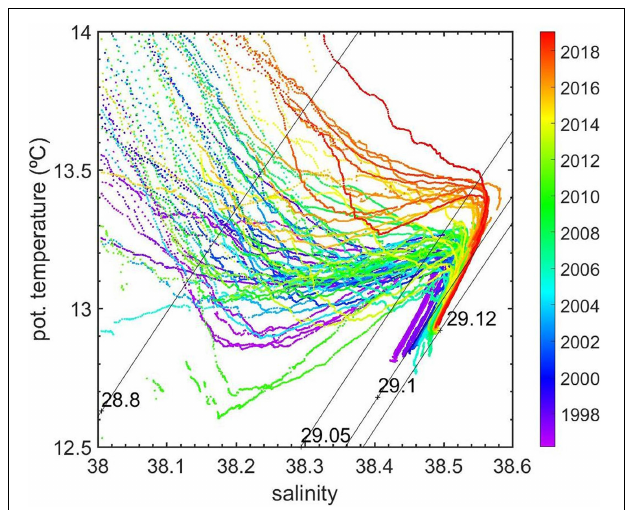
FIGURE 2 | Potential temperature-salinity ( θ S ) diagrams for the complete time series from 1996 to 2019. For each of the 71 oceanographic campaigns, one single θ -S diagram is presented, averaging the data from all the oceanographic stations forming the four sections that cover the Balearic Channels. The color scale shows the time corresponding to each survey. Some specific isopycnals have been included. WIW would have a potential density higher than 28.8 and lower than 29.05. The 29.05 isopycnal could be associated to the LIW core, and the 29.1 would be representative of the WMDW previously to the WMT. The 29.12 is also included as this density value is observed after the